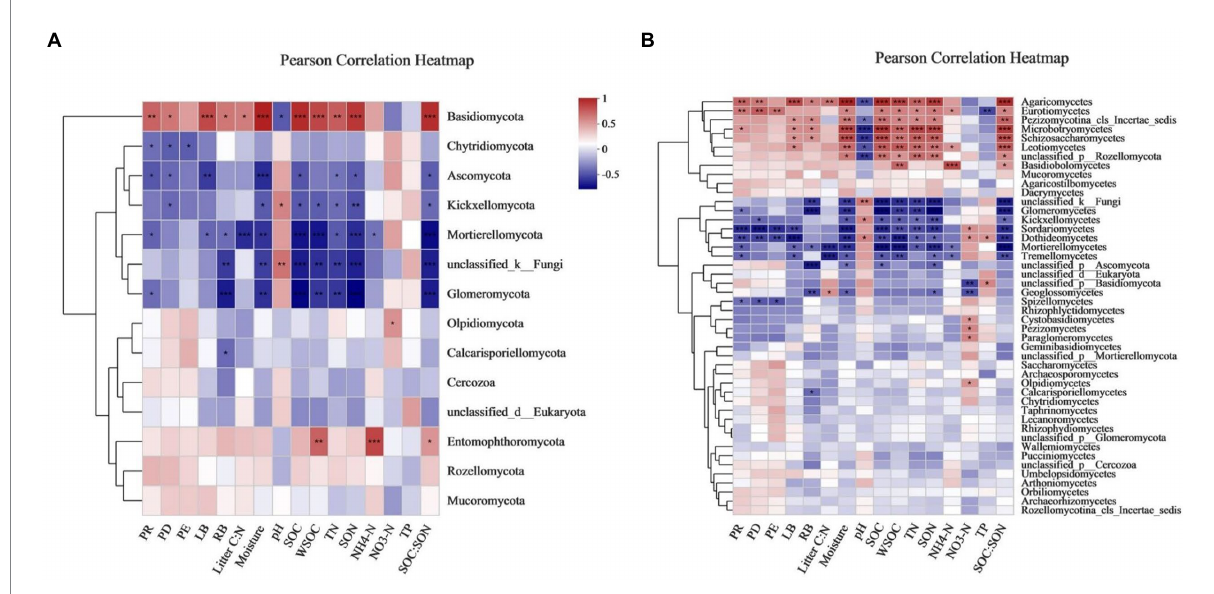
FIGURE 7 Heat map of the Pearson correlation between the bacterial (A) phyla and (B) class with environmental variables. Figure 6 for